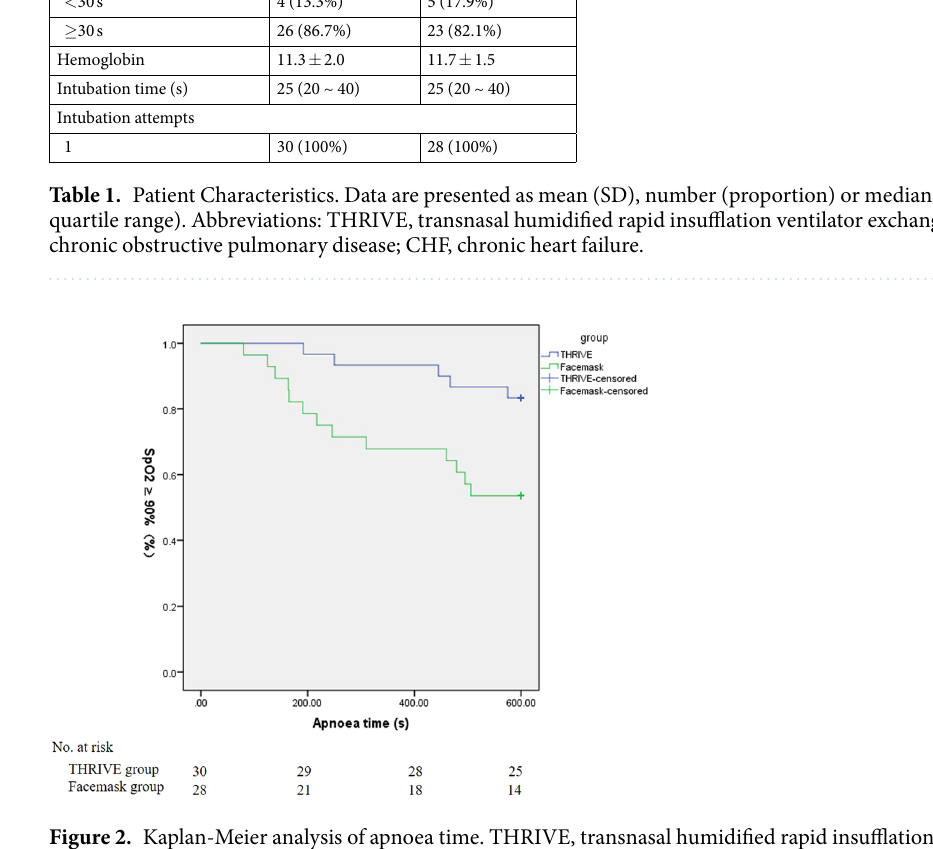
Figure 2. Kaplan-Meier analysis of apnoea time. THRIVE, transnasal humidified rapid insufflation ventilator